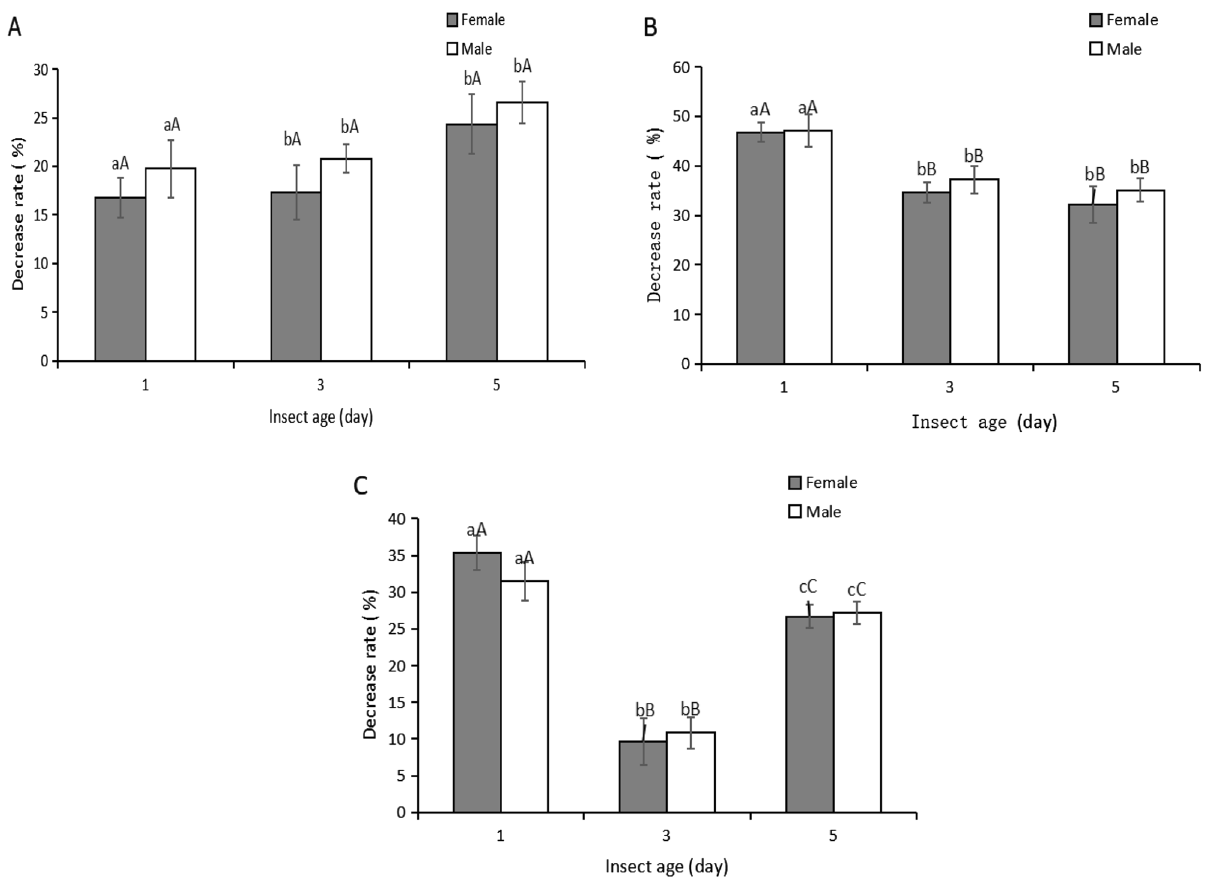
Figure 3. Decrease rate of juvenile hormone III titers of Monochamus alternatus adults with difference ages in the presence of ultrasound of LHC20. Bars are the mean ± SE for n = 324 of total numbers of M. alternatus adults across all three replicates. Different letters with the different bars indicate significant differences at the 5% and 1% level. ( A ) 1 h ultrasound exposed; ( B ) 12 h ultrasound exposed; ( C ) 24 h ultrasound exposed.